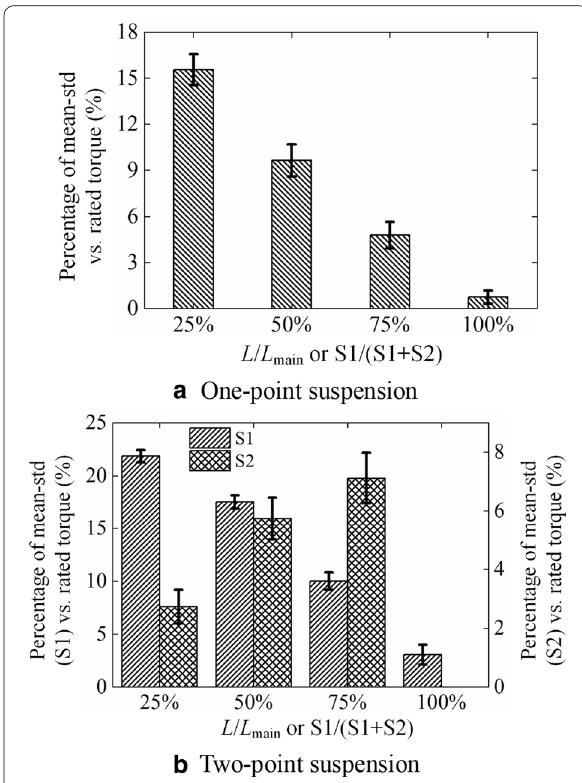
Figure 11 Main shaft bending forces in two suspension